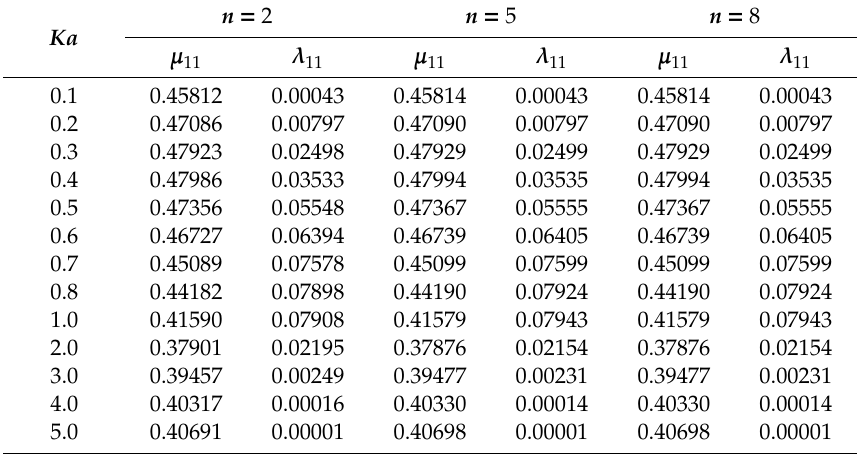
Table 1. Convergence sequence of the normalized surge added mass and damping coe ffi cients